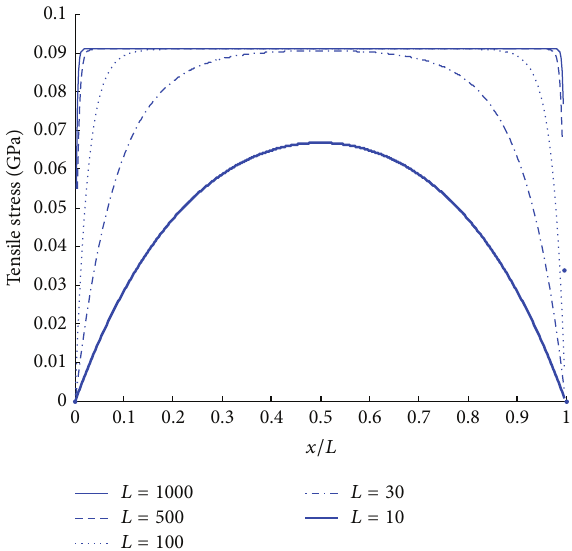
Figure 8: Tensile stress distributions at various tube lengths pro- vided by van der Waals force ( 𝑑 = 3 nm, 𝑡 = 0.34 nm).